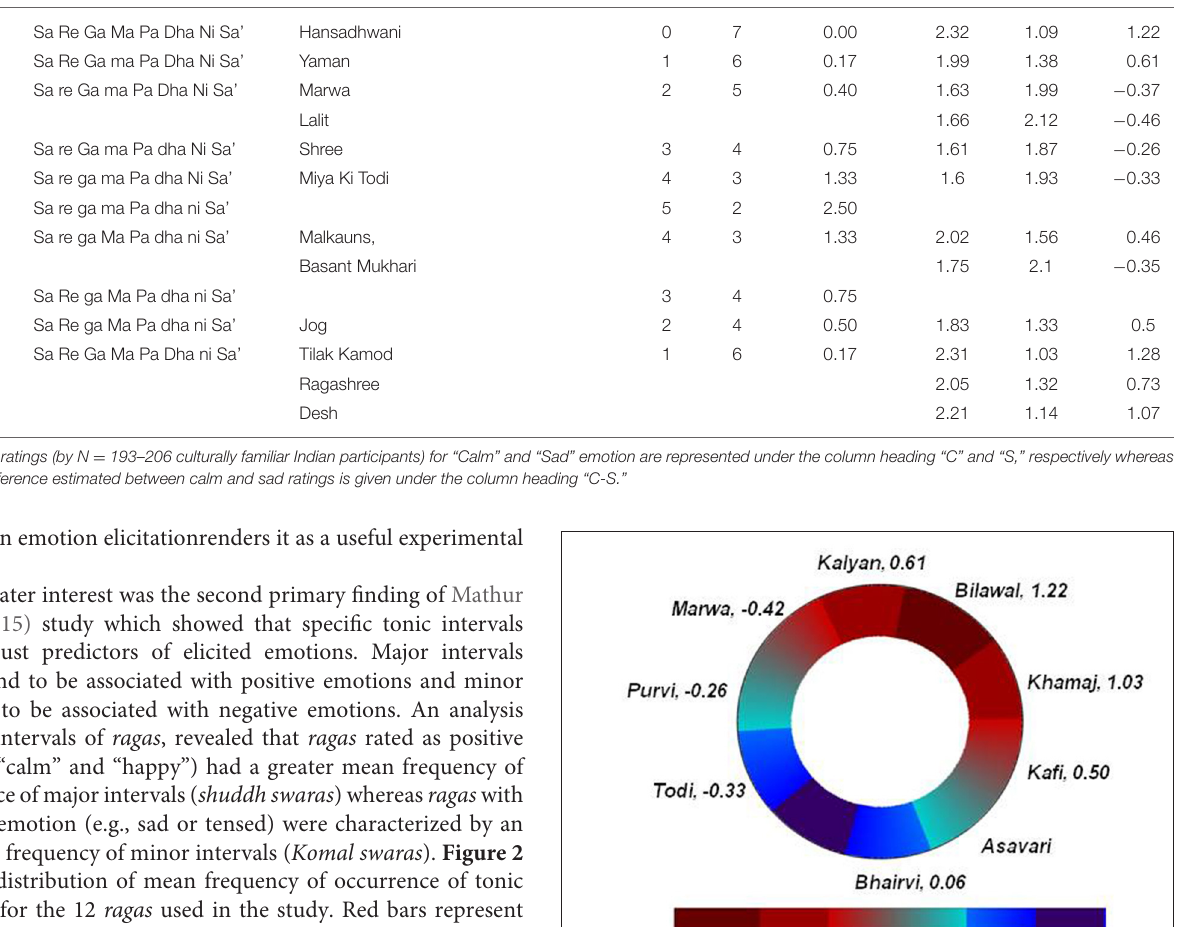
TABLE 2 | Ratios of minor (m) to major (M) intervals along with mean ratings for ragas belonging to each thaat as estimated in Mathur et al. (2015). That Scale Ragas used by Mathur et al. (2015)